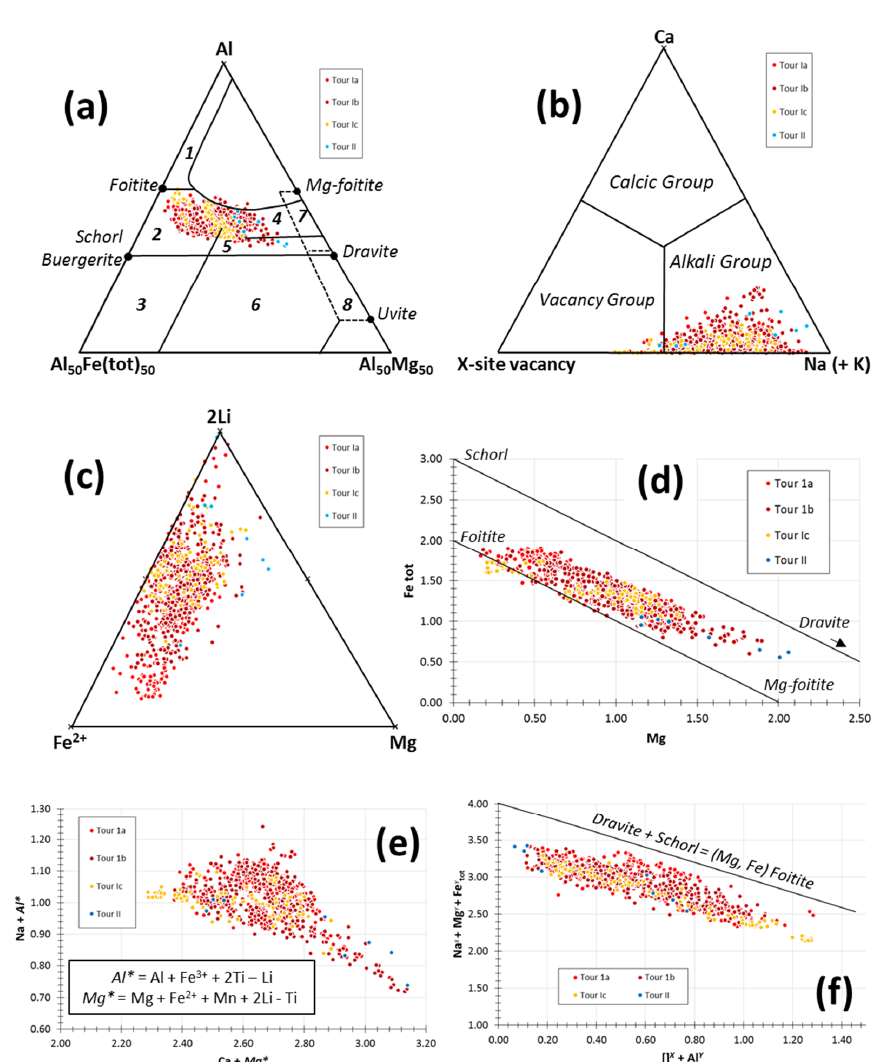
Figure 7. Ternary classification plots of tourmaline in terms of ( a ) Al-Fe-Mg contents [156] and ( b ) Ca–X-site vacancy–Na ( + K) [158]. The fields in ( a ) denote typical tourmaline compositions from: 1 , Li-rich granitoid, pegmatite, aplites; 2 , Li-poor granitoids, pegmatites, aplites; 3 , Fe 3+ -rich quartz-tourmaline rocks; 4 , metapelites and metapsammites with an Al-saturating phase; 5 , metapelites and metapsammites without and Al-saturating phase; 6 , Fe 3+ -rich quartz-tourmaline rocks, calc-silicate rocks, and metapelites; 7 , low-Ca metaultramafics and Cr-, V-rich metasediments; and 8 , meta-carbonates and metapyroxenites. Compositional variation of the analyzed tourmalines considering the Fe 2+ – 2Li – Mg abundances ( c ). Scatter diagrams showing the predominant ion exchanges operating in these tourmalines ( d – f ; also see [158–160]); values in atoms per formula unit.